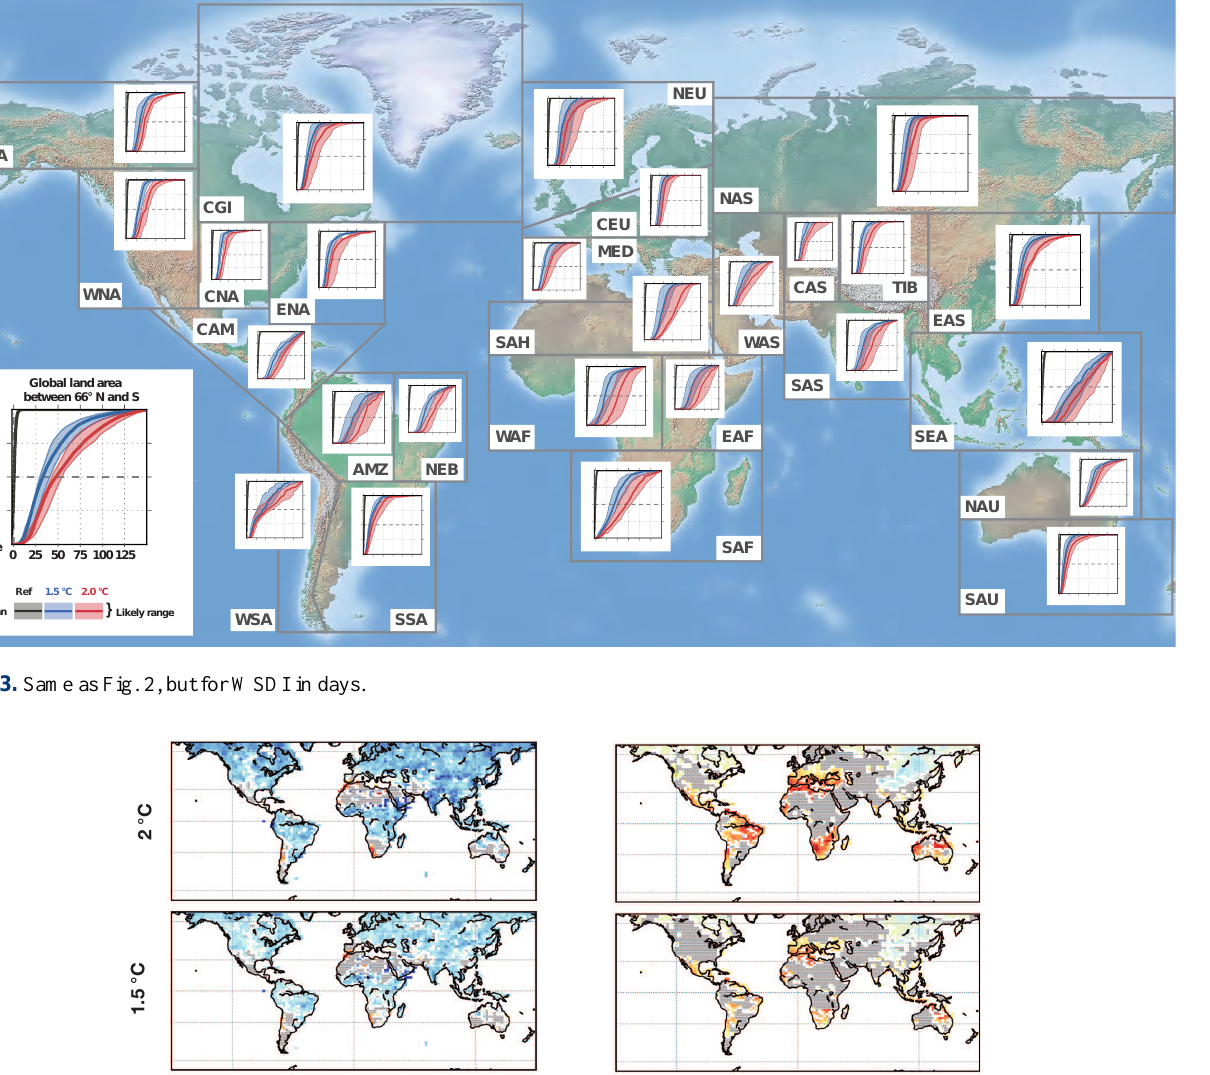
Figure 4. Same as Fig. 1, but for RX5day and CDD. Hatched areas indicate regions, where less than 66% of the models in the ensemble agree with the sign of change of the median